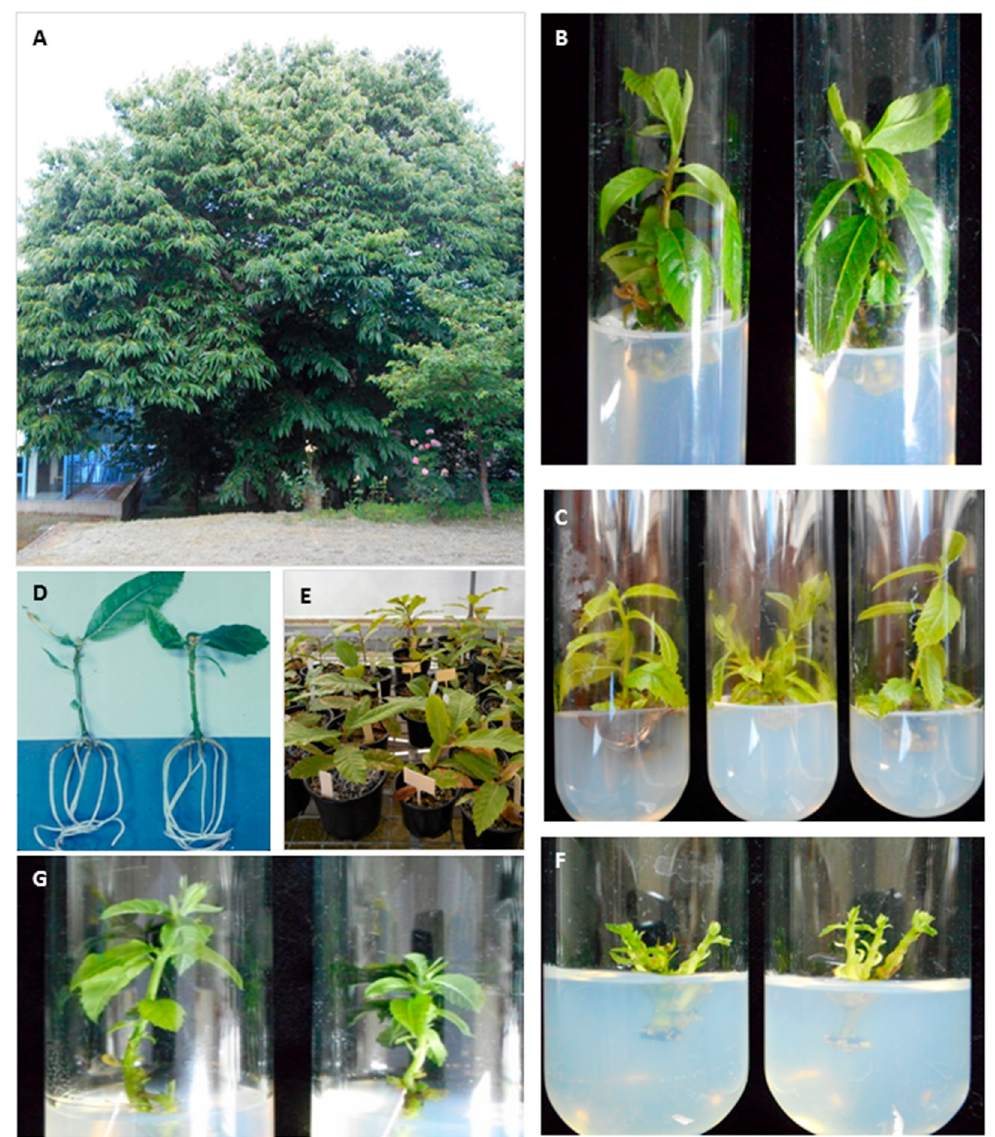
Figure 1. ( A ) Adult example of Castanea sativa × C. crenata cv HV (Vieitez hybrid) resistant to ink disease. ( B ) In vitro multiplication by proliferation of axillary buds in chestnut material of juvenile origin. ( C ) In vitro multiplication of C. sativa × C. crenata cultures selected for the size of their fruits (cv. Marigoule, left) and the quality of the wood (cv 431, the two on the right.). ( D ) In vitro rooting of axillary shoots of C. sativa in Gresshoff and Doy medium with 25 mg/L indole butyric acid for 24 h. ( E ) Chestnut plants from in vitro culture, subsequently acclimatized in the greenhouse. ( F ) Chestnut shoots after one year of storage at 4 °C. ( G ) The same shoots stored in cold ( F ) after four weeks in multiplication medium (Gresshoff and Doy supplemented with 0.1 mg/L BA).